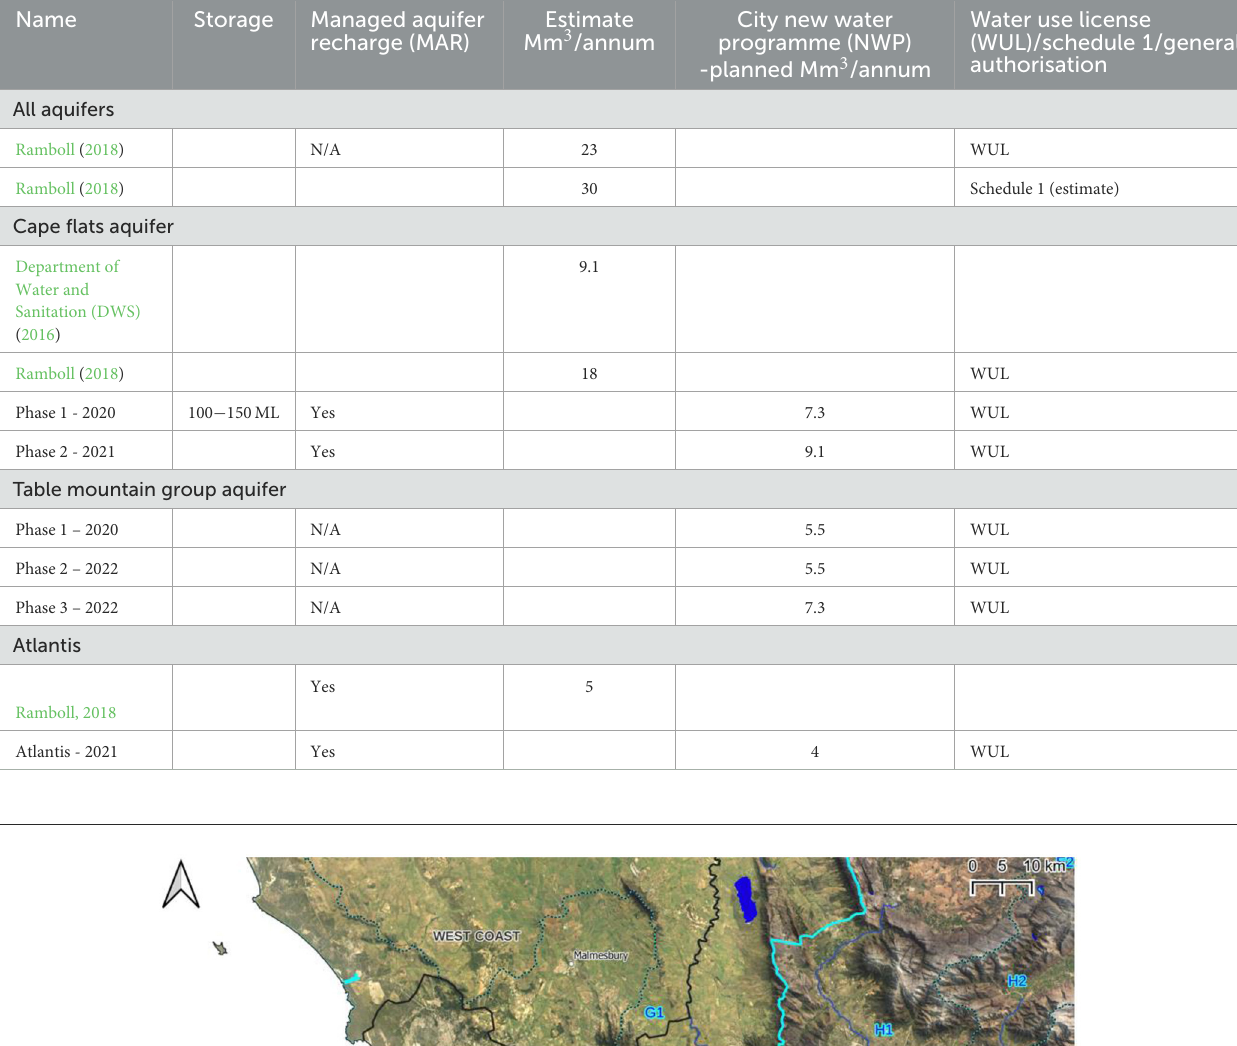
TABLE 2 Consolidation of groundwater abstraction volumes as per Ramboll (2018) and City of Cape Town (2019b).